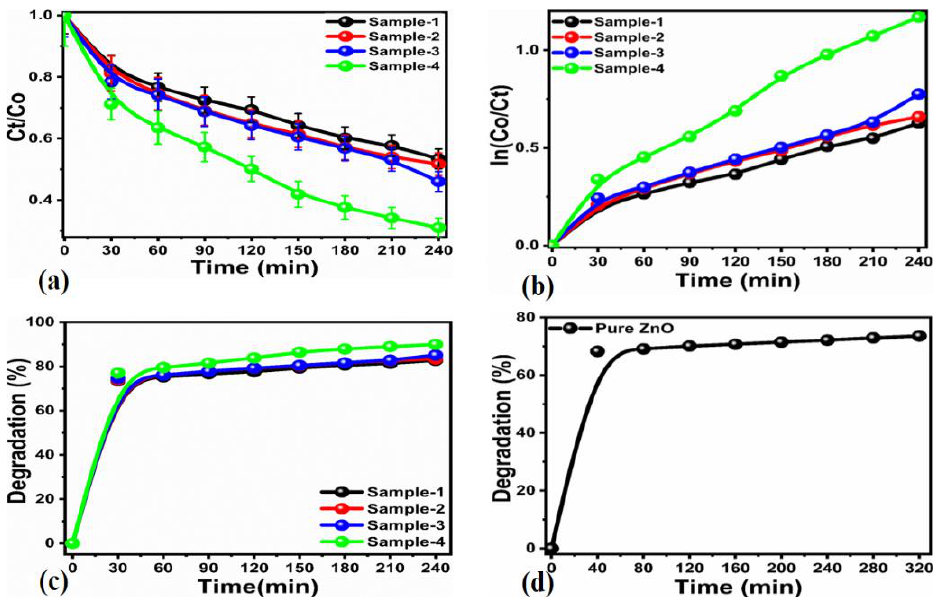
Figure 9. Degradation kinetics ( a ) kinetics C t / C o irradiation time, ( b ) Ln C t / C o plot, ( c ) percent degradation of MO, ( d ) degradation percentage of pure ZnO over MO.